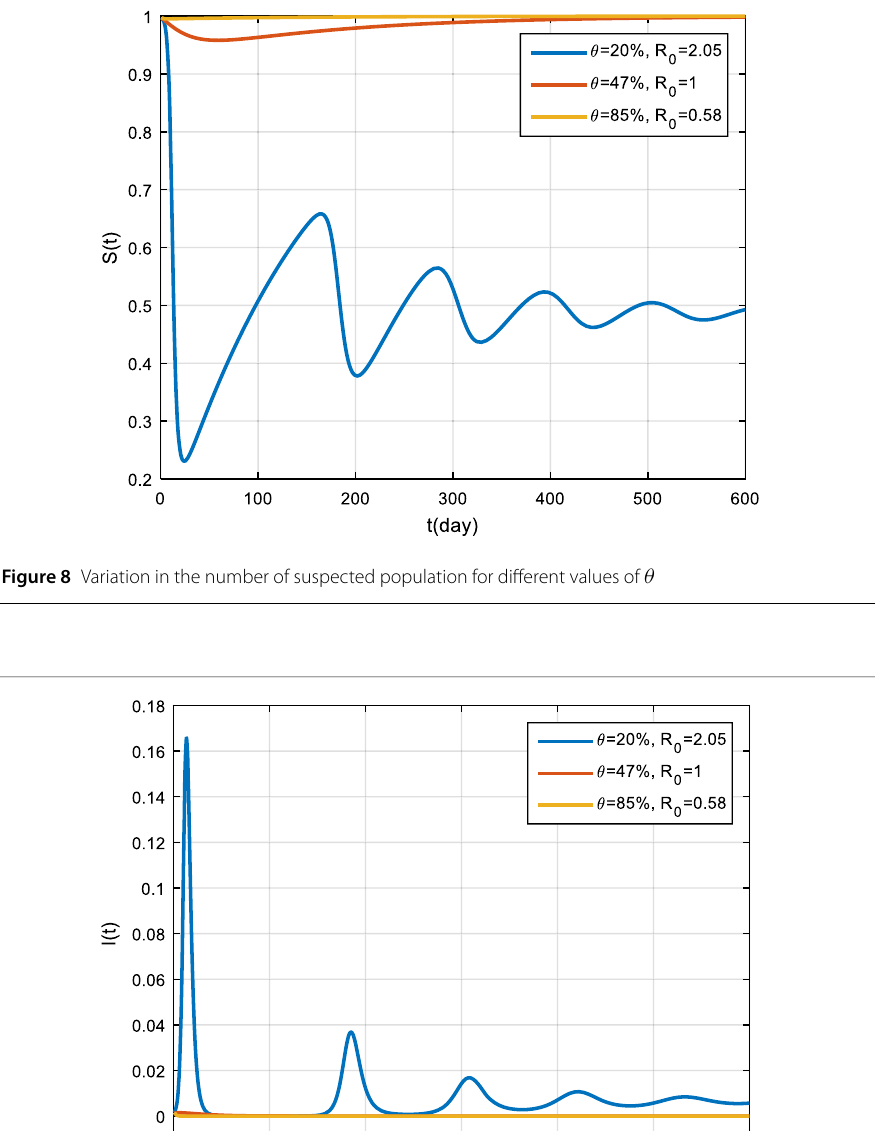
treatment is 20% without vaccination and without implementing health protocols, it can reduce the basic reproductive number to 2.13 so that a person with COVID-19 can infect two other people. However, if the effectiveness of the treatment reaches 85%, then the ba- sic reproduction number is reduced to 0.58, which means that the spread of COVID-19